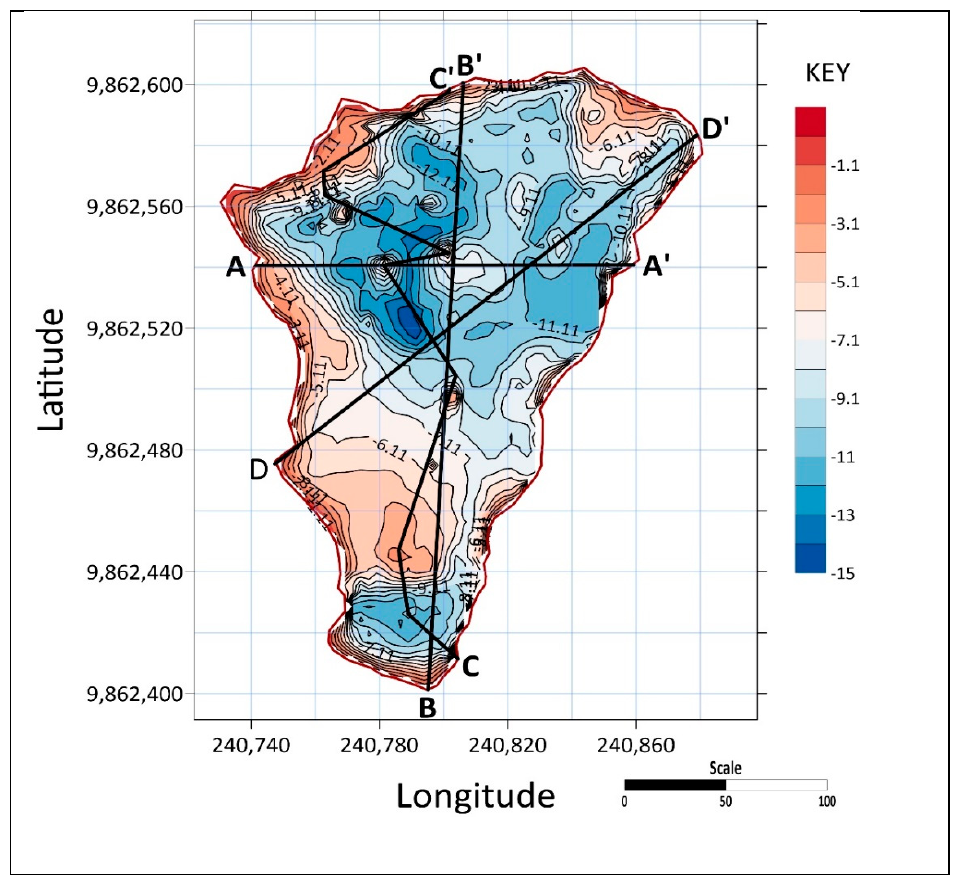
Figure 6. Depth contours of Rungiri quarry reservoir.